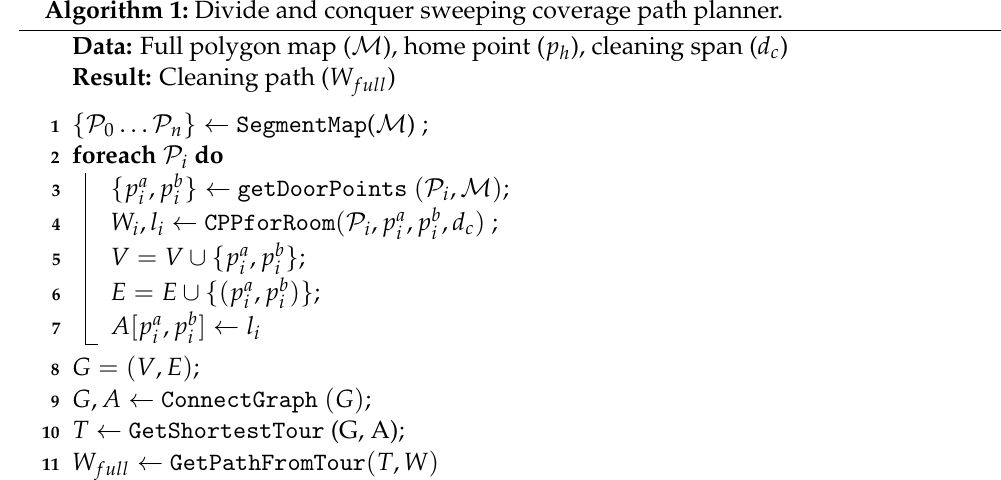
Algorithm 1: Divide and conquer sweeping coverage path planner.